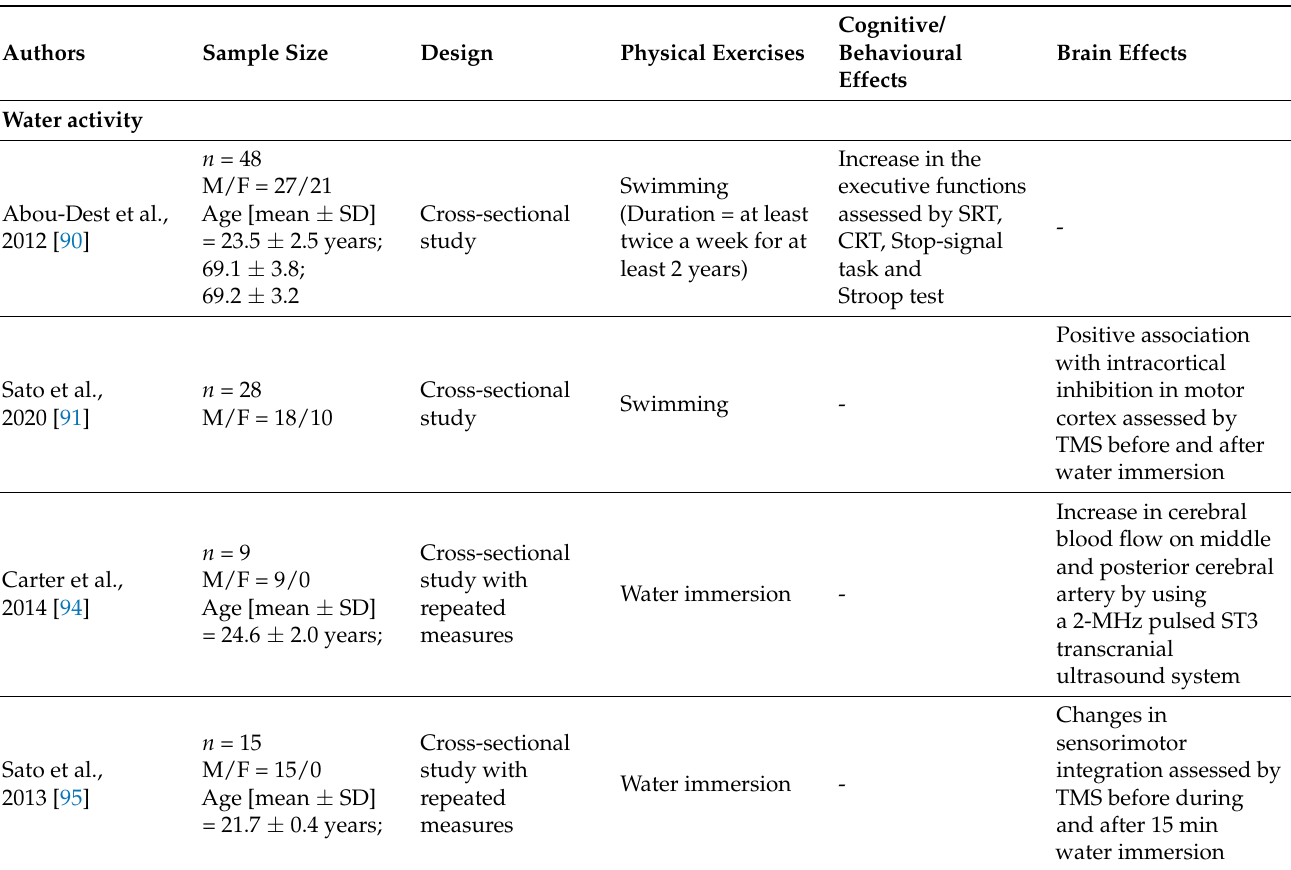
Table 4. Studies on water activity effects on cognitive functions and neural substrates of healthy human